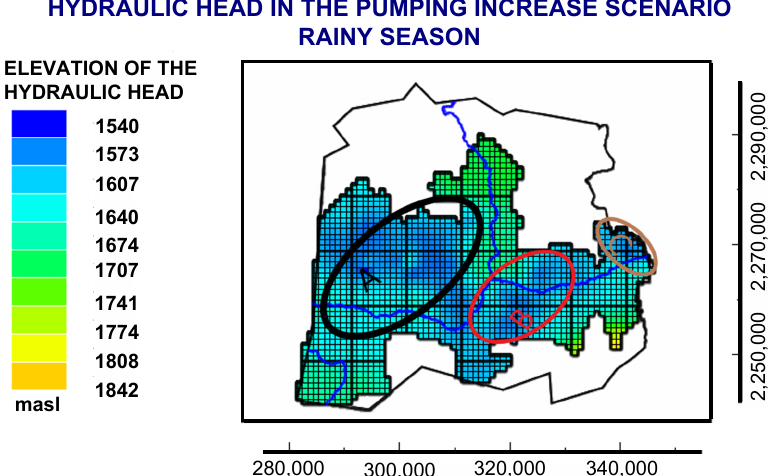
Figure 21. Elevation of the hydraulic head of the year 2030 through the pumping increase scenario in the rainy Figura 3.9: Elevaci´on de la carga hidr´aulica del a˜no 2030 a trav´es del escenario Aumento de Bombeo en la Temporada de Lluvias.